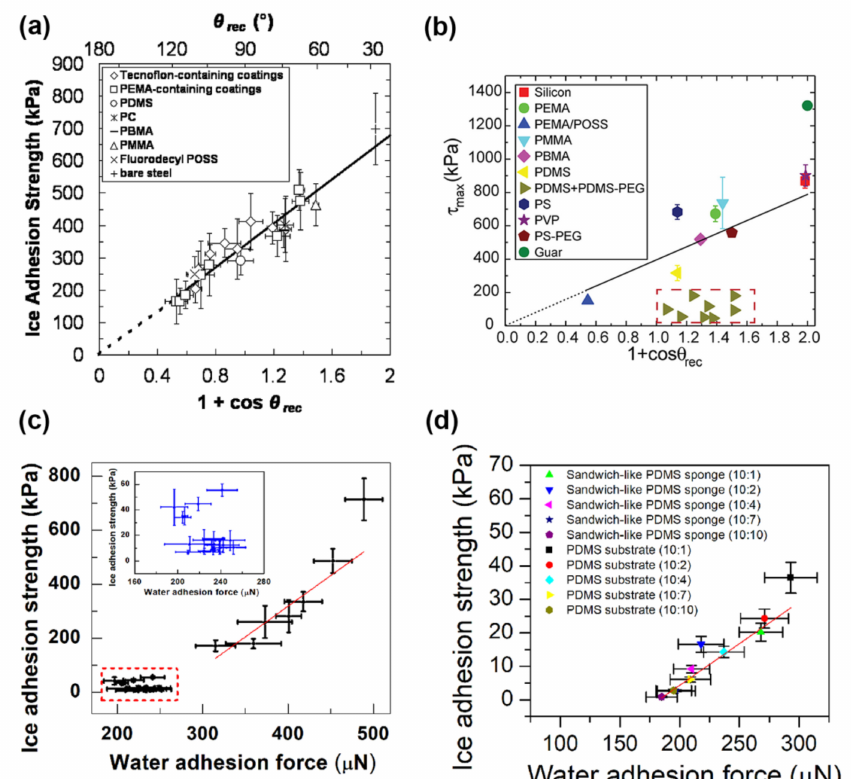
Figure 7. Correlations between ice adhesion strength and the value of (1 + cos θ rec ): ( a ) ice adhesion strength measured at − 10 ◦ C for bare steel and 21 different coatings; ( b ) ice adhesion strength mea- sured at − 15 ◦ C for 17 different polymer coatings and a bare clean silicon wafer. Correlations between ice adhesion strength and water adhesion force (i.e., the water adhesion force was investigated by a Dynamic Contact Angle Tensiometer (DCAT11s, dataphysics) at room temperature): ( c ) 24 different coatings; and ( d ) 10 PDMS-based coatings. ( a ) Reproduced from Ref. [1] with permission, Copyright 2010 American Chemical Society; ( b ) reproduced from Ref. [75] with permission, Copyright 2017 American Chemical Society; ( c ) reproduced from Ref. [5] with permission, Copyright 2017 Springer Nature Publishing AG; and ( d ) reproduced from Ref. [2] with permission, Copyright 2018 the Royal Society of